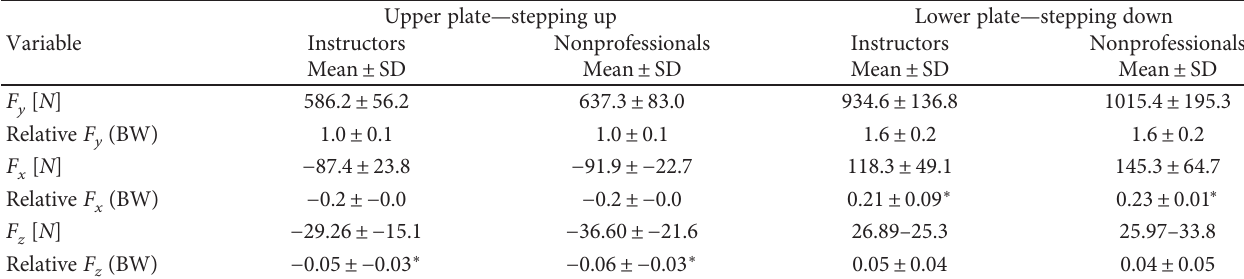
Table 1: Mean values and standard deviation (SD) of the GRF vector for the instructors and nonprofessionals recorded by the upper and lower Kistler force